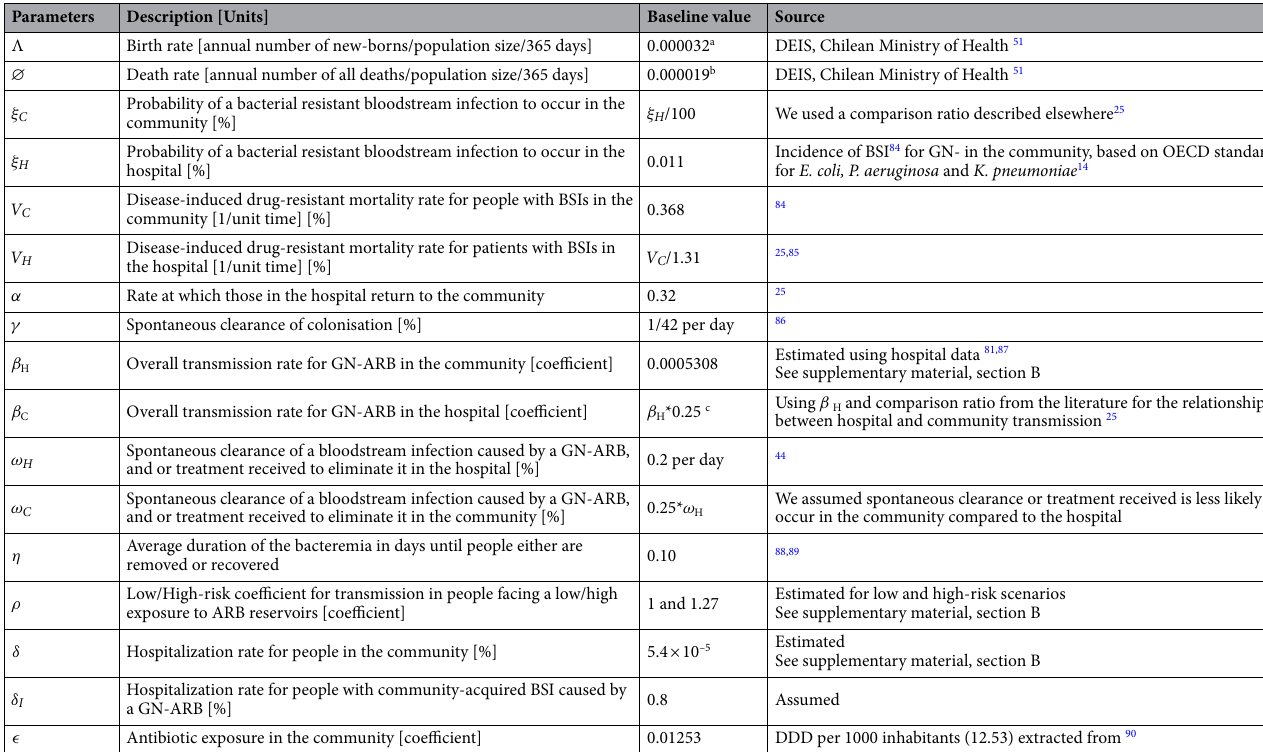
Table 2. Parameters of the compartment model for GN- transmission. DDD stands for defined daily dose; DEIS: Dirección de Estadísticas en Información en Salud; GN-ARB: gram-negative antibiotic resistance; OECD: Organization for Economic Co-operation and Development. a [542/45,976]/365. b [314/45,976]/365. c